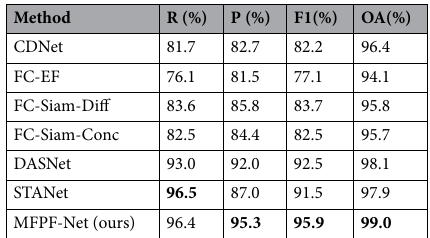
Table 2. Comparison of CDD dataset results (the best performance is emphasized in bold).